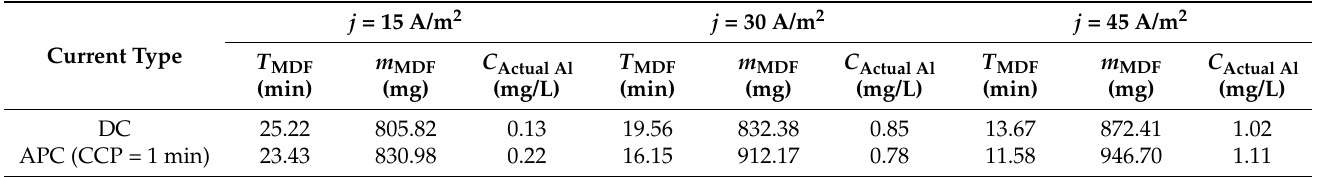
Table 3. Effects of APC on the T MDF , m MDF , and C Actual Al in MDF